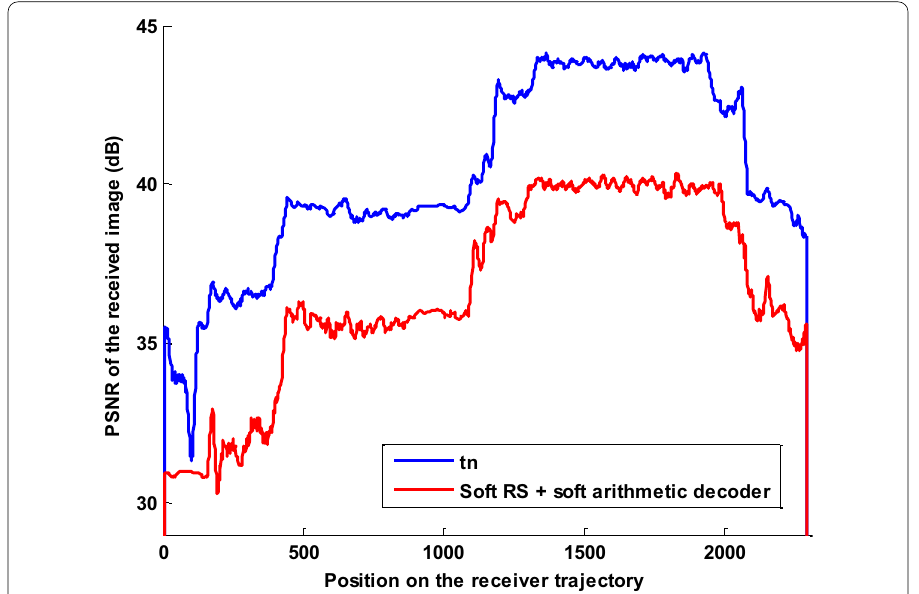
Fig. 14 PSNR of Lena image. A PSNR comparison for the Lena image between the proposed scheme and the one presented in [16] through the reception trajectory